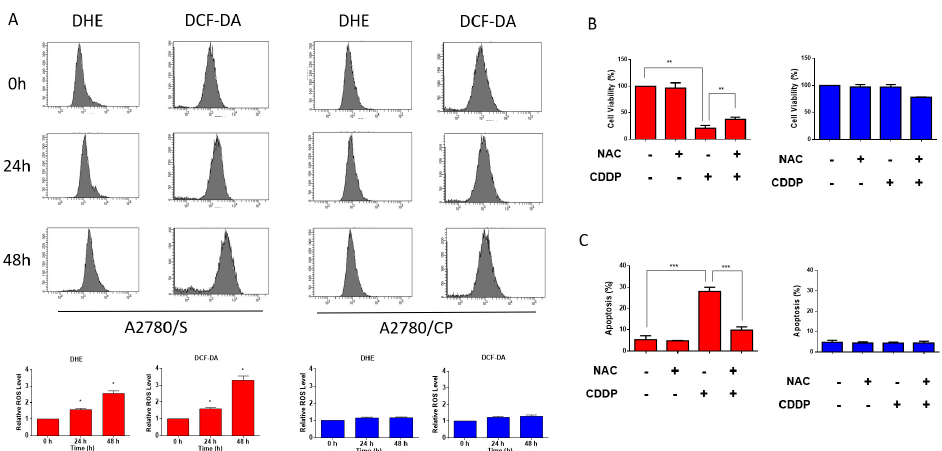
Figure 2. The A2780 / S and A2780 / CP cells were treated with cisplatin (2 µ M) for 24 and 48 h. The intracellular reactive oxygen species (ROS) levels were measured through staining by flow cytometric assay using dihydroethidium (DHE) ( A ) and 2,7-dichloro-dihydrofluorescein diacetate (DCFH-DA) ( B ) staining. The A2780 / S and A2780 / CP cells were treated with cisplatin (2 µ M) only or cotreated with NAC. Cell viability was accessed using an MTT assay ( B ) and cell apoptosis was determined using flow cytometry ( C ). Results are shown as mean ± SEM (* p ≤ 0.05, ** p ≤ 0.01, *** p ≤ 0.001).